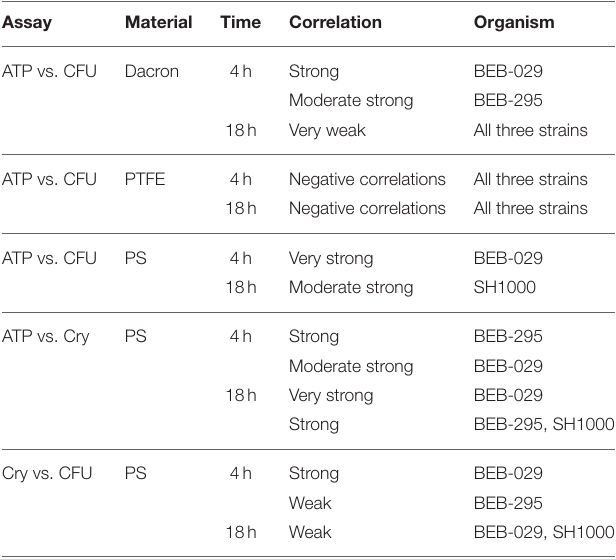
TABLE 1 | Pearson’s correlation coefficient of the S. aureus strains on the different materials (Dacron or polystyrene) for ATP vs. CFU, ATP vs. Cry, and CFU vs. Cry. Assay Material Time Correlation Organism ATP vs. CFU